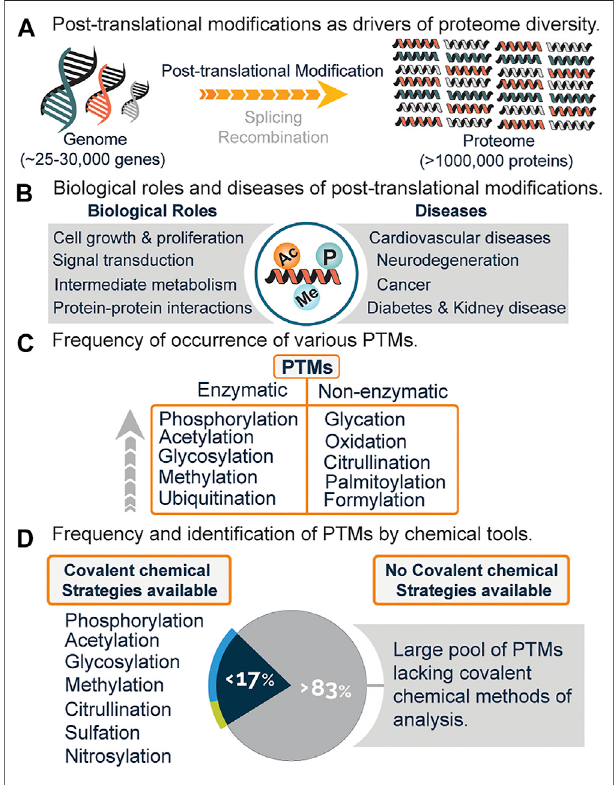
FIGURE 1 | (A) Increased protein diversity due to post-translational modi fi cations (PTMs), alternative splicing, and recombination. (B) Biological rolesanddiseasesassociatedwithPTMs. (C) FrequencyofvariousPTMsand mode of generation i.e., enzymatic or non-enzymatic. (D) Estimated PTMs thathavecovalentchemicalpro fi lingstrategies andthe lackofchemical strategies for a signi fi cant percentage of PTMs.